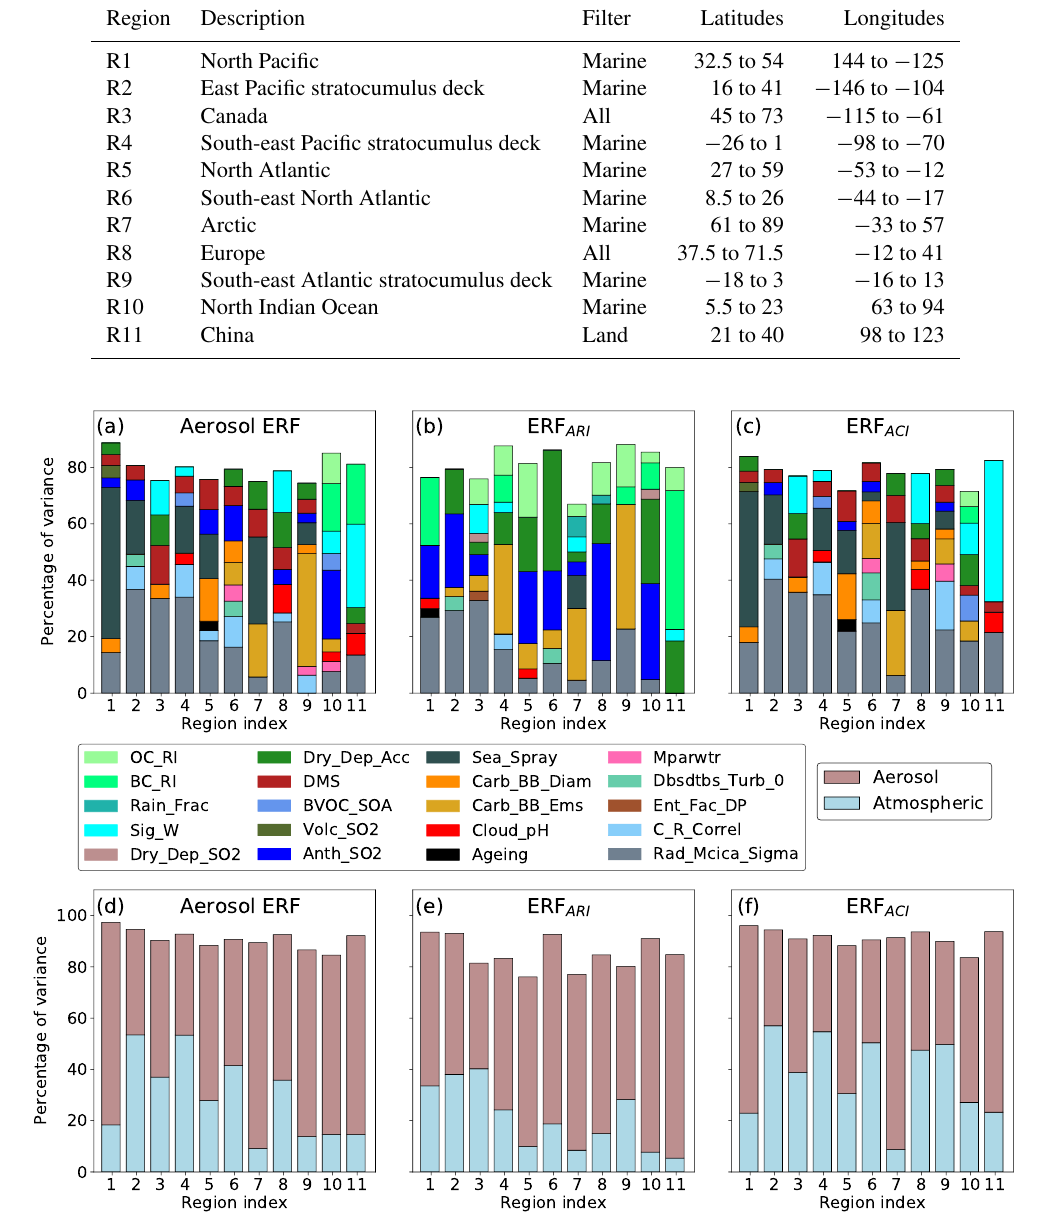
Table 3. Latitude and longitude boundaries for regions R1–R11. Some regional averages are filtered to include only marine or non-marine data.